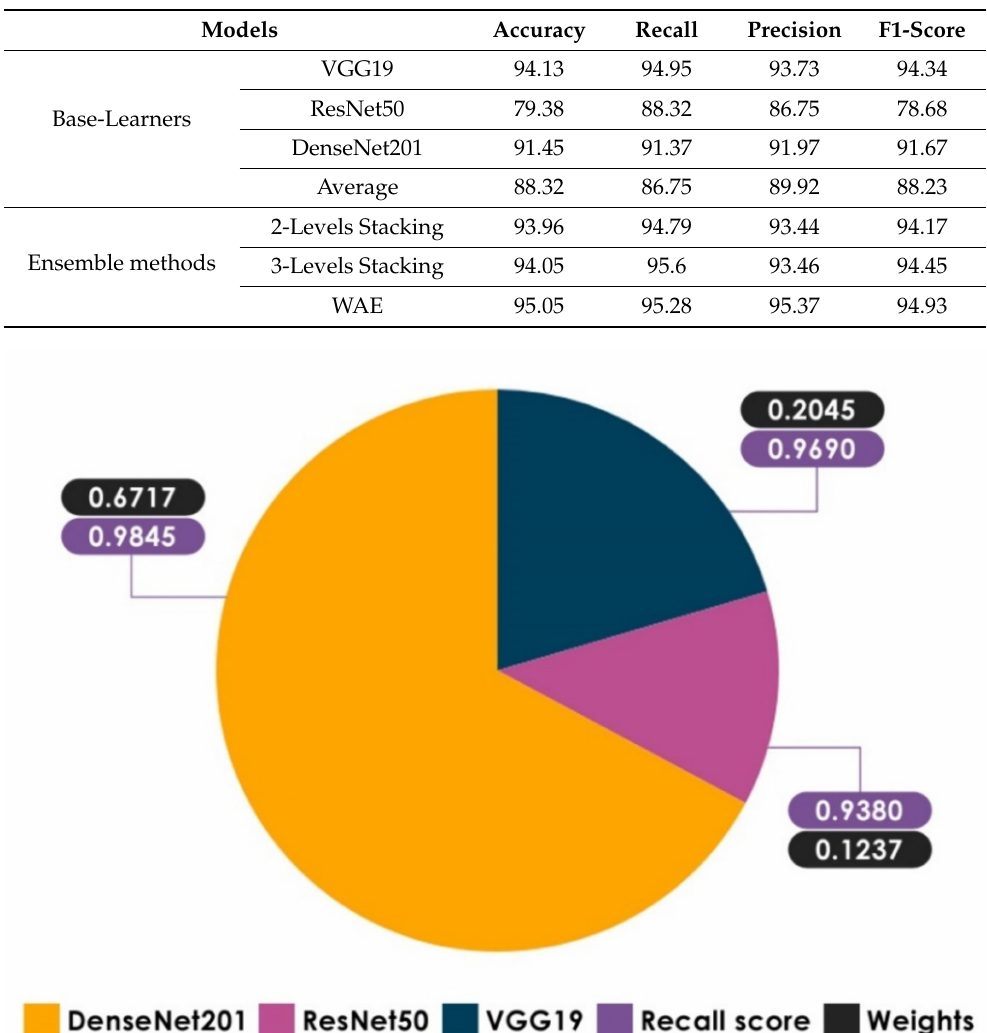
Table 8. Comparison among the proposed ensemble methods and the Base-Learners on the COVID- CT dataset [22].